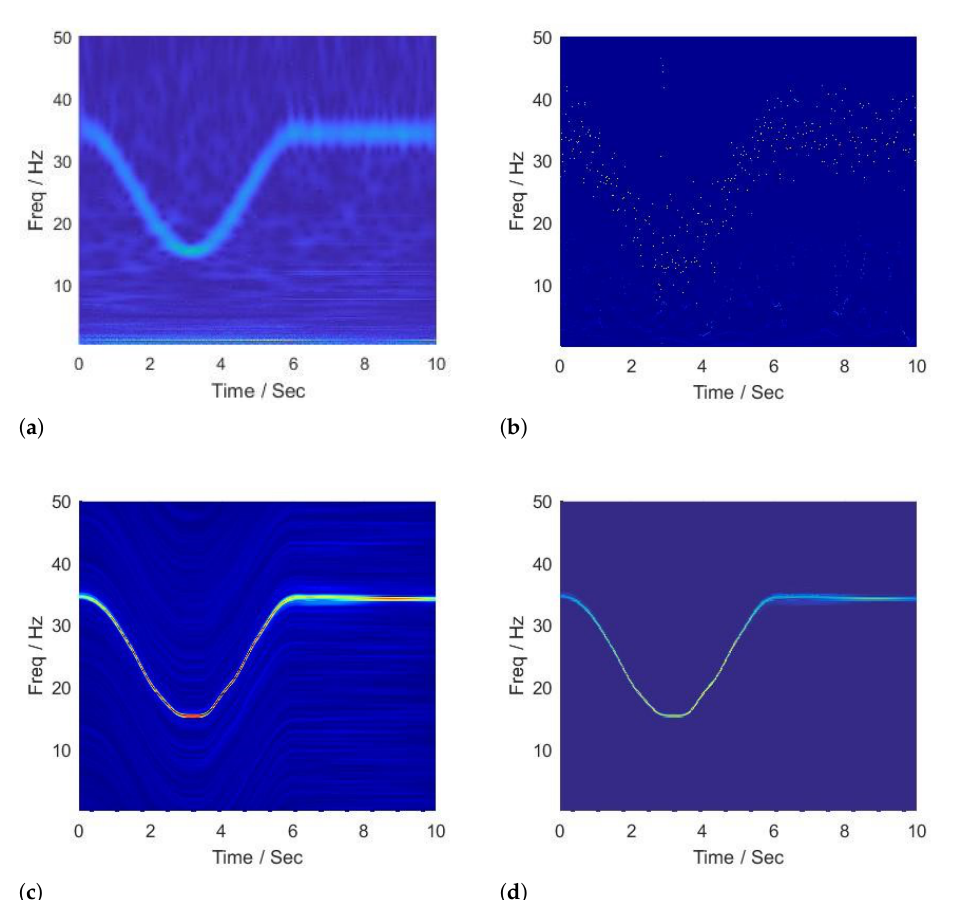
Figure 1. Time-frequency analysis of signal with instantaneous frequency in Equation (19) by ( a ) CWT, ( b ) HHT, ( c ) SCT, and ( d )